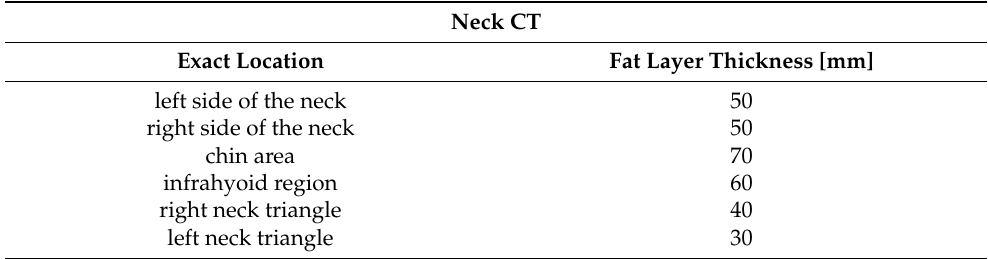
Table 1. Computed tomography of the neck. The exact location of adipose tissue overgrowth and measurement of its